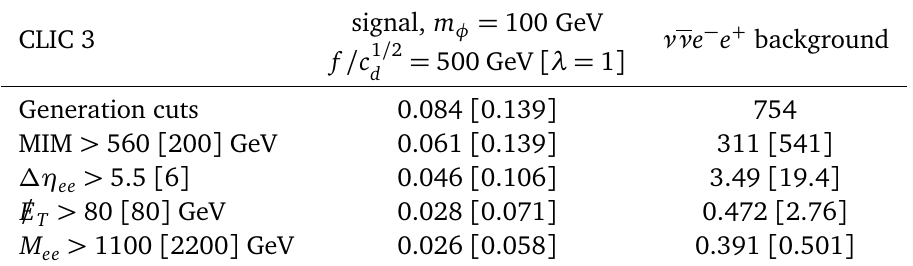
Table 4: Cross sections in fb. For 3 ab − 1 we have S = 2.2 [ 4.2 ] for the deriva- tive [ marginal ] portal. No EFT consistency condition is